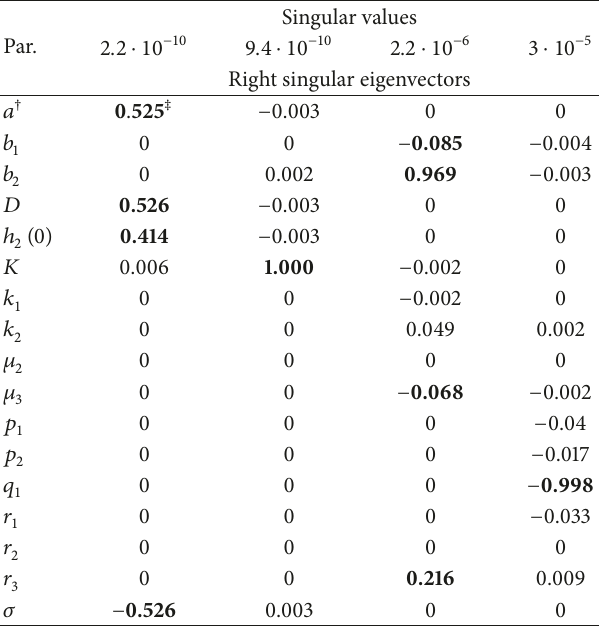
Table 1: The four smallest singular values of Figure 4 with their corresponding eigenvectors. Singular values Par. (1) Disentangling the various causes of nonidentifiability assessed with sensitivity-based approaches, actually providing some additional information helpful for experiment design (a priori) and for the interpreta- tion of parameter estimation results (a posteriori) (2) Exactly knowing the analytic relations between the correlated parameters (3) Reducing the model’s complexity by redefining an identifiable model equivalent to the original one but with a reduced number of unknown parameters (4) Making the parameter identification process from real data more rigorous and